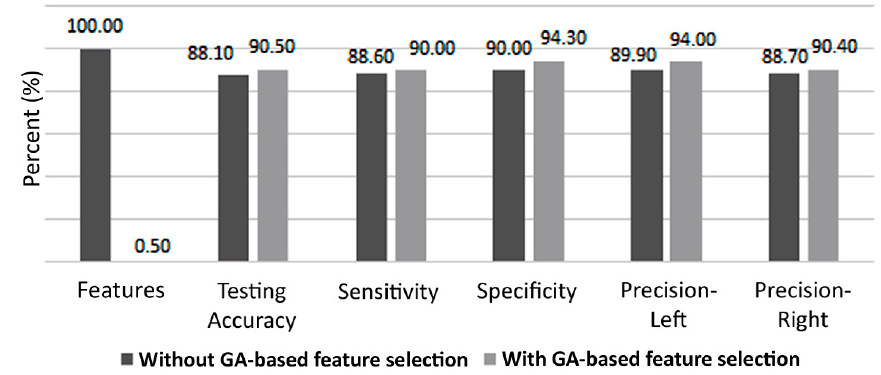
Figure 9. Classification results (12,336 vs. 61 features).